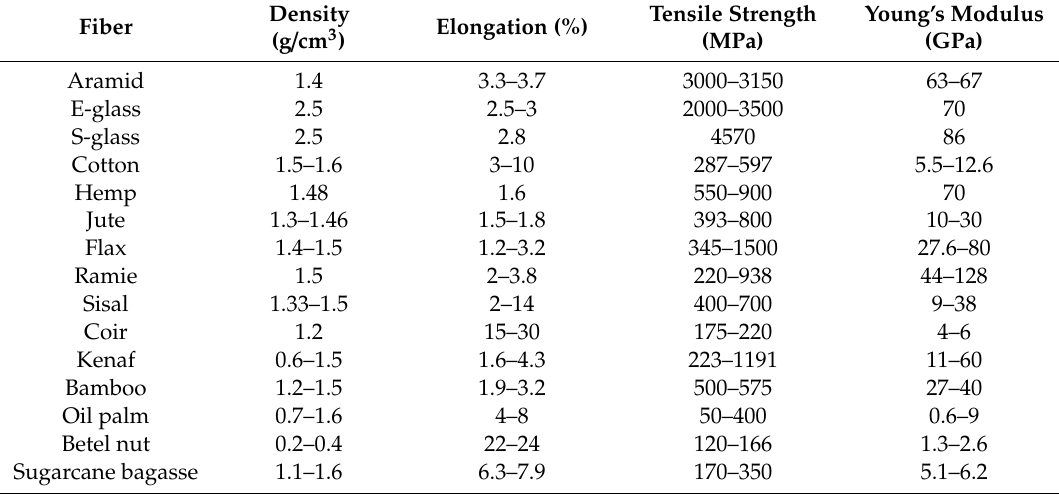
Table 2. Some significant properties of frequently used fiber materials